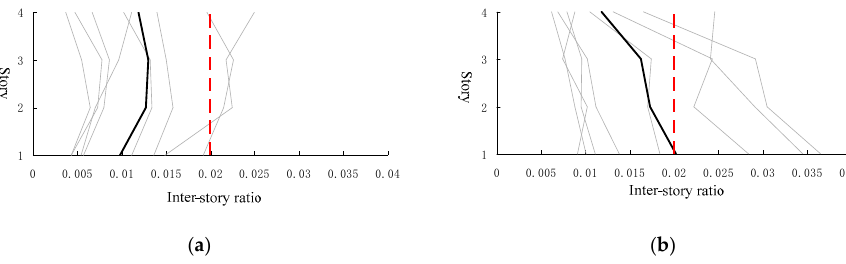
Figure 19. Inter-story drift responses of both structures ( PGA = 0.51 g). ( a ) The dual structure; ( b ) The bare frame structure. Table 7. Input ground motions for the seismic performance assessment.